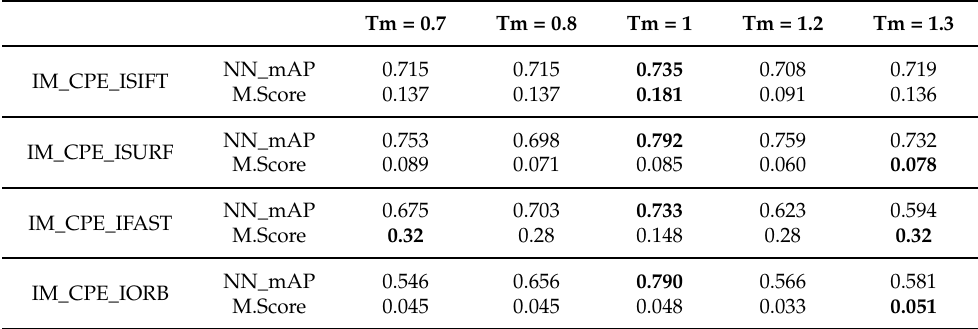
Table 4. Comparison of results of IM_CPE using four kinds of key points with various T M s in terms of NN_mAP and M.Score in ‘walking rpy’